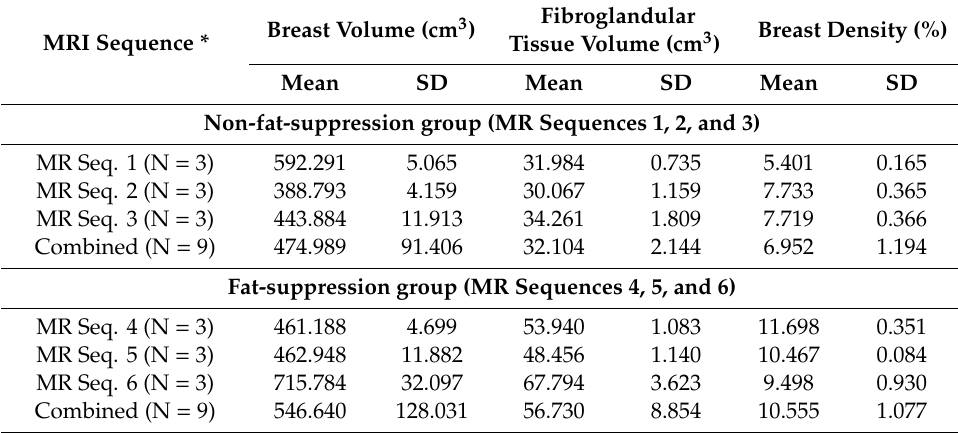
Table 2. Results of the estimated mean and standard deviation of breast volume, fibroglandular tissue volume, and percentage of breast density for the di ff erent MRI sequences using a personalized 3D-printed breast model.